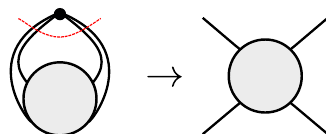
Figure 20: Excision of a quartic vertex from a vacuum bubble (left) leads to a graph with 4 external legs